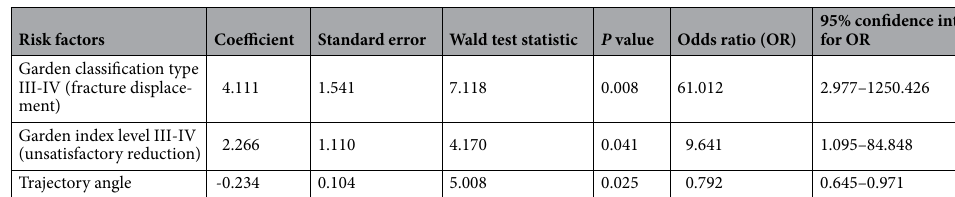
Table 6. The multivariate logistic regression analysis of the risk factors for femoral head necrosis.